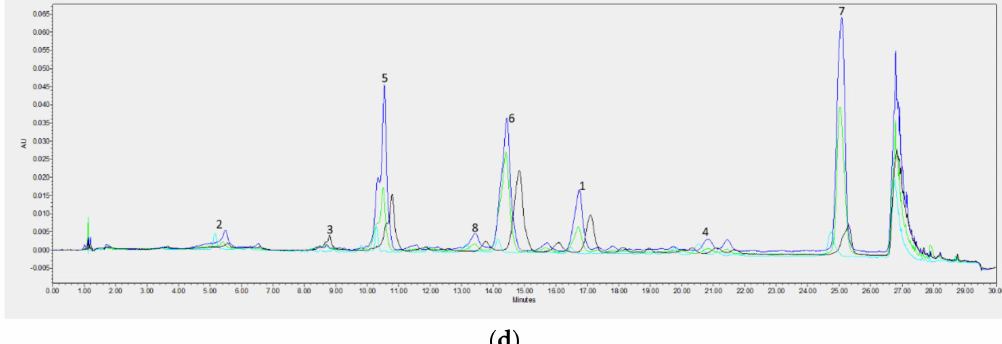
Figure 1. Representative chromatograms elderberry fruits extracts from UPLC/PAD of samples ( a )–phenolic acids, ( b )– flavonoids and a comparison of the most diversified samples (samples 5, 18, 20, and 36) ( c )–phenolic acids ( d )–flavonoids. (phenolic acids: 1–gallic acid, 2–4-hydroxybenzoic acid, 3–vanillic acid, 4–syringic acid, 5–vanilin, 6–benzoic acid, 7– chlorogenic acid, 8–protocatechuic acid, 9–salicylic acid, 10–caffeic acid, 11–p-coumaric acid, 12–ferulic acid, 13–sinapic acid, 14–t-cinnamic acid, 15–rosmarinic acid; flavonoids: 1–apigenin, 2–catechin, 3–kaempferol, 4–luteoline, 5–naringenin, 6–quercetin, 7–rutin, 8–vitexin).